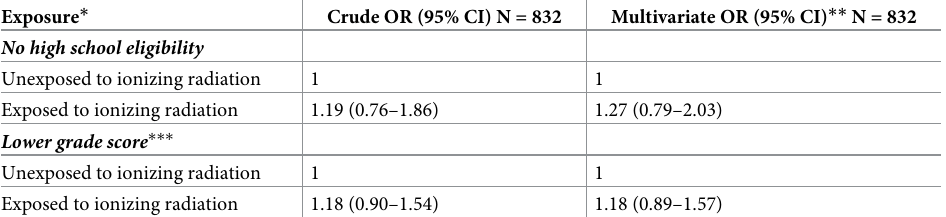
Table 3. Crude and multivariate comparisons of participants exposed and unexposed to ionizing radiation in not having high school eligibility and having lower grade scores.